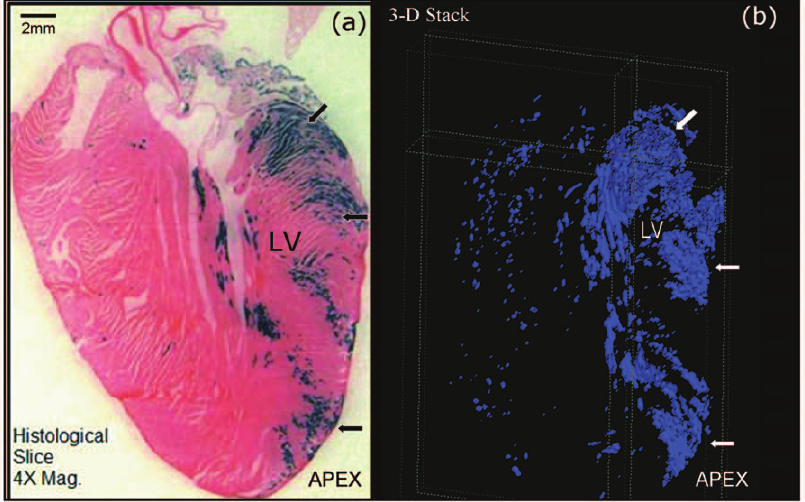
Figure 3. Three-dimensional (3D) reconstruction of the XGAL + staining in the Pnmt + /Cre , ROSA26 + / b gal heart. (a) Representative two- dimensional section of the adult mouse heart were cut at 20 microns. (b) Still-shot of a 3D-rendered image generated from stacked 2D images as described in the methods section. The arrows point to equivalent regions in both panels that roughly correspond to basal, mid, and apical concentrations of XGAL + cells in these hearts. Please see online supplemental figures 1 and 2 for different perspective views of the 3D image analysis for these data.